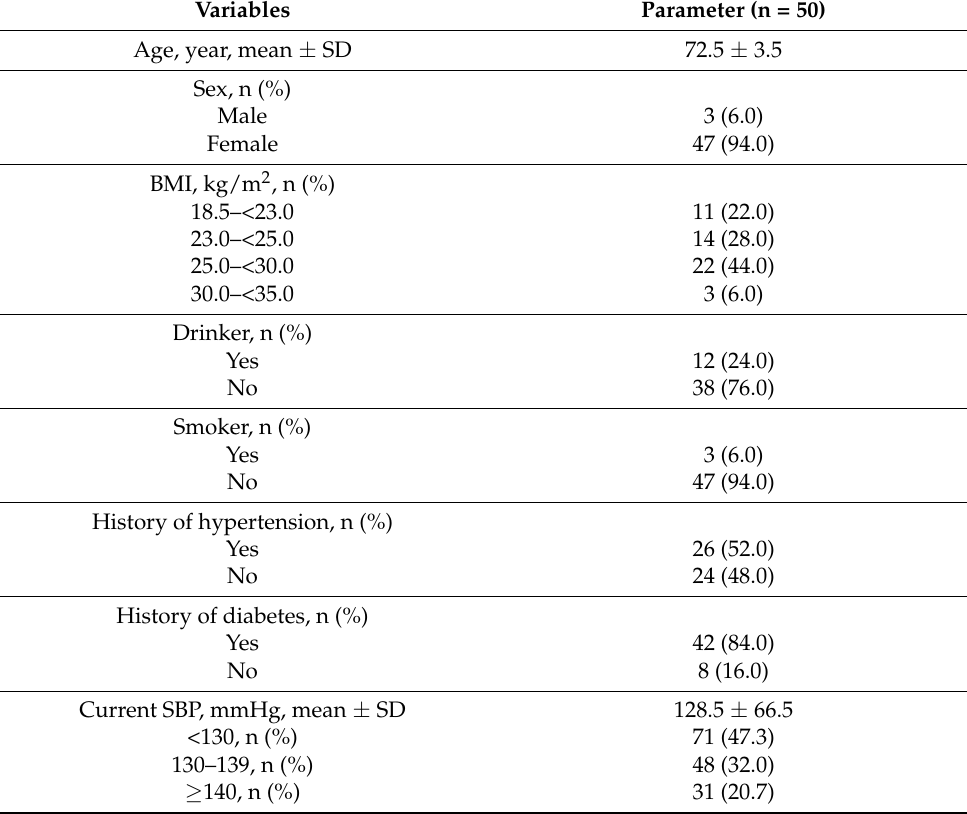
Table 1. Information about study